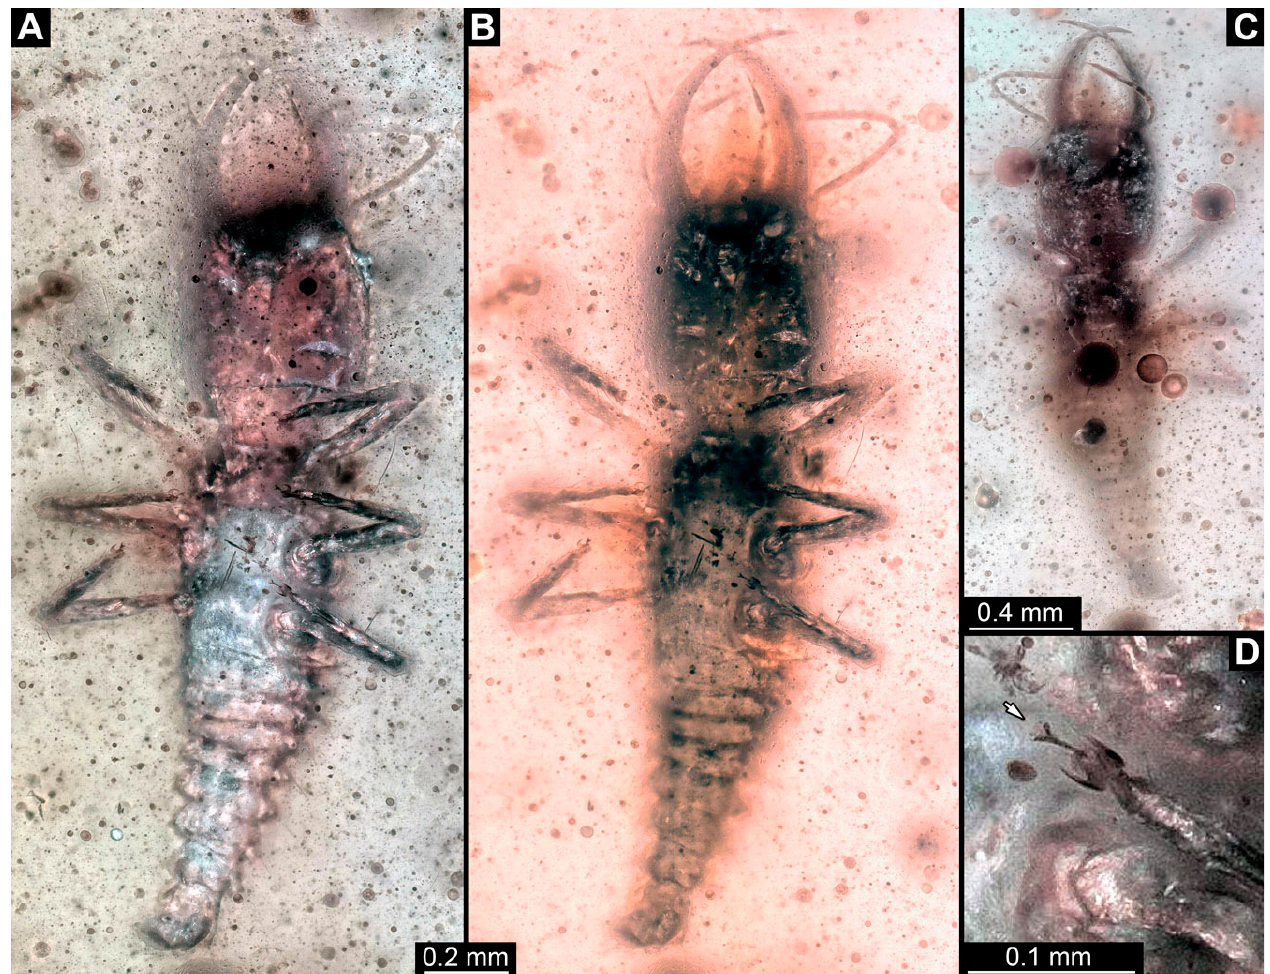
Figure 25. Specimen 90 (PED 2171); Myanmar amber. ( A , B ) Ventral view under different illumina- tions. ( C ) Dorsal view. ( D ) Close-up of locomotory appendages; arrow marks empodium. (39) Specimen 91 (PED 2309) is preserved in Cretaceous amber from Myanmar (Figure 26). The specimen is well accessible in the ventral (Figure 26A,B) and dorsal views (Figure 26C), but is partly concealed by Verlumung and dirt particles in the dorsal and ventral views. The labrum is prominent, being triangular symmetric to trapezium-like and relatively elongated (Figure 26D). The antennae bear prominent setae distally (Figure 26E). Each distal end of the walking appendages bears a trumpet-shaped empodium (Figure 26F). The specimen has an approximate length of 2.2 mm.